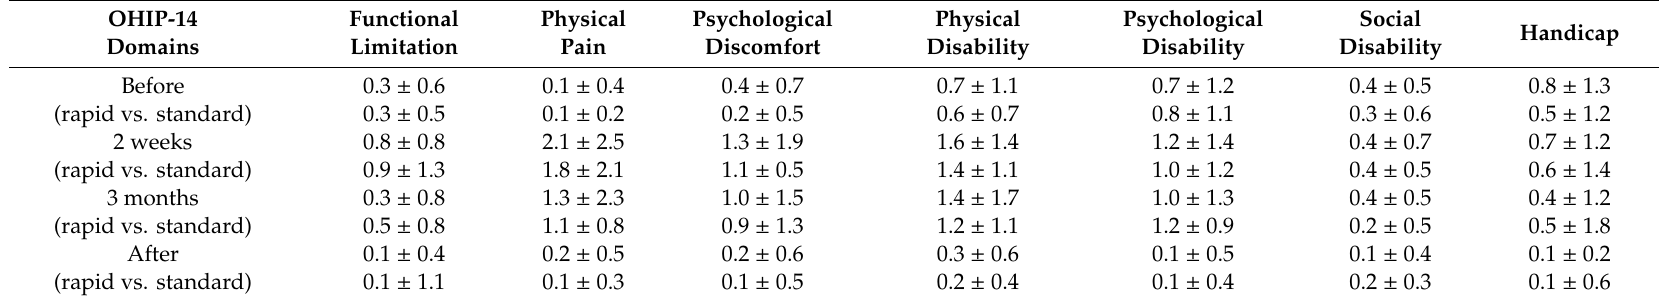
Table 5. The mean OHIP-14 score for individual domains observed before, during, and after orthodontic treatment for the two groups of cancer survivors: with rapid and standard duration of orthodontic treatment.